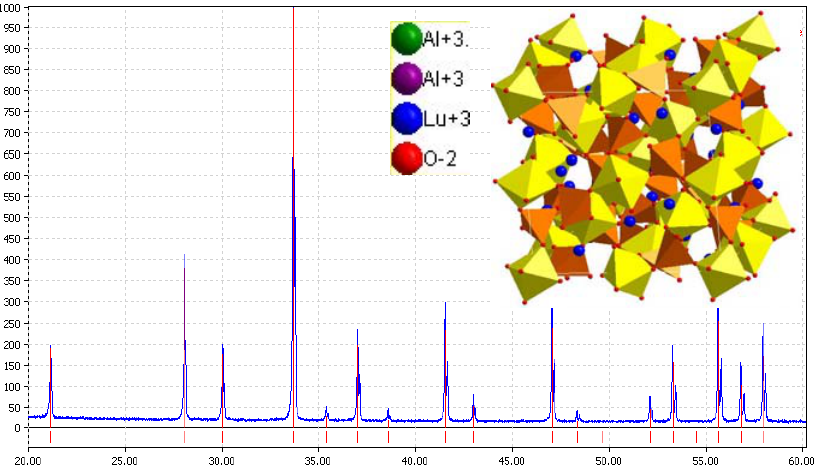
Ce ) Al O 0.9 0.01 3 5 13